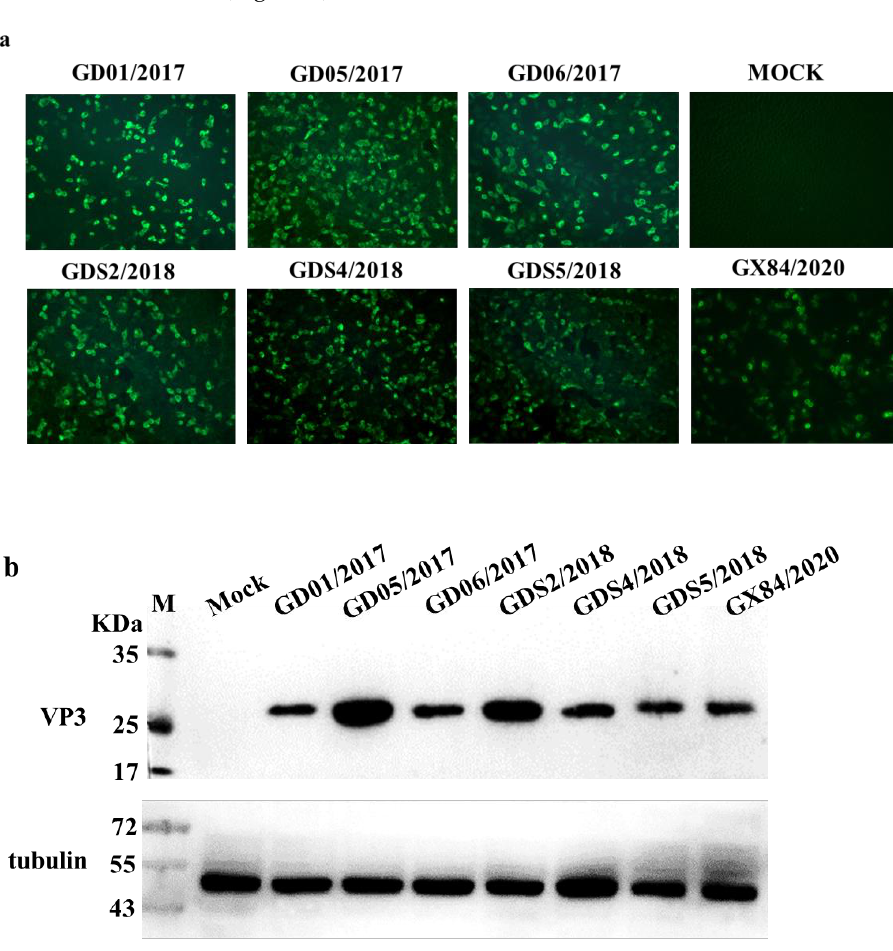
Figure 4. Identification of Reactivity of mAb 3E9 to different SVA strains by IFA ( a ) and Western blot ( b ). The reactivity of mAb 3E9 to ST-R cells infected by different SVA strains was analyzed. Normal ST-R cells were used as a negative control.